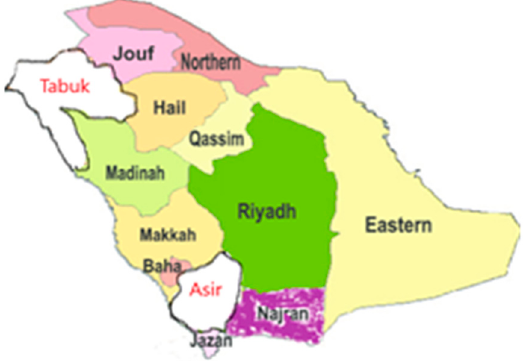
Figure 2. Region wise map of Saudi Arabia. The two study regions of Tabuk and Asir are labelled with red color.